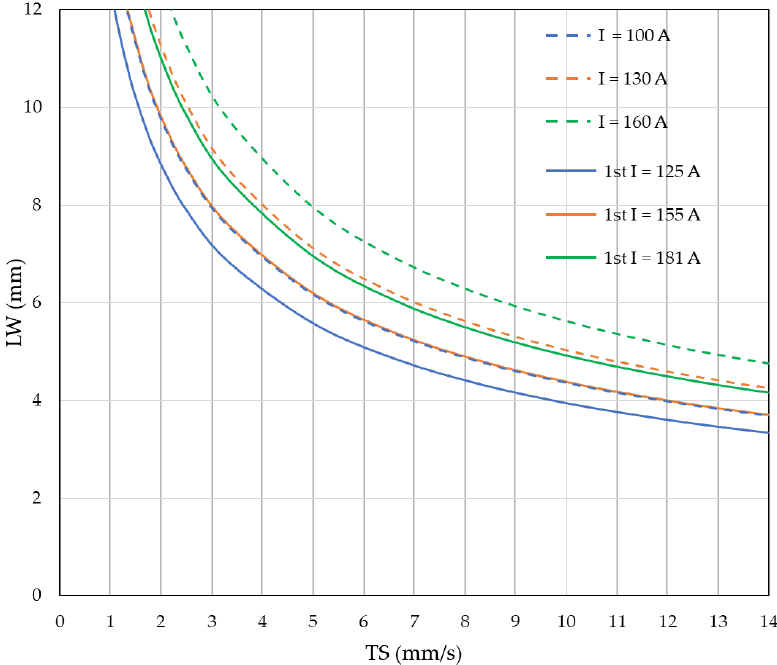
Figure 9. Second approximation operational map representing the boundaries for the actual workable currents (LW is still estimated by Equation (5)) superimposed on first approximation operational map (dashed line), already shown in Figure 6.